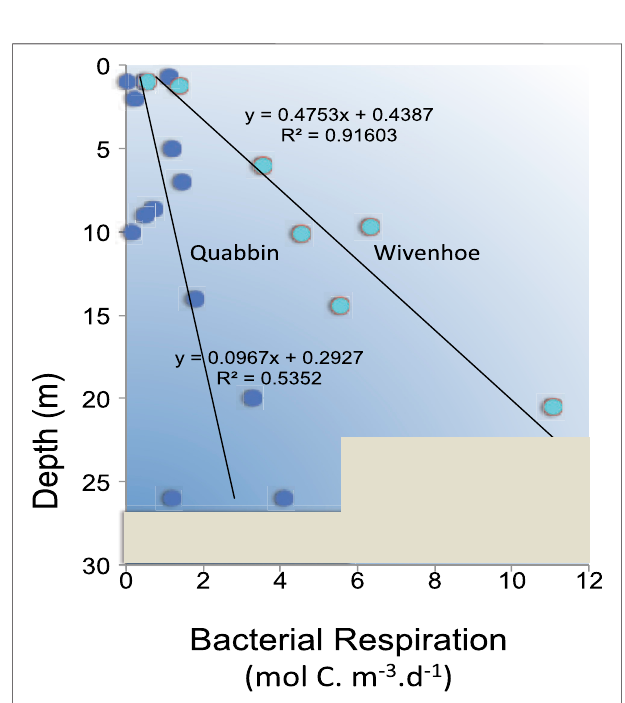
FIGURE 6 | Bacterial respiration is plotted as a function of water depth for two major reservoirs. In each case highest mineralisation rates or organic carbon were at the bottom of each reservoir. The blocked are represents the